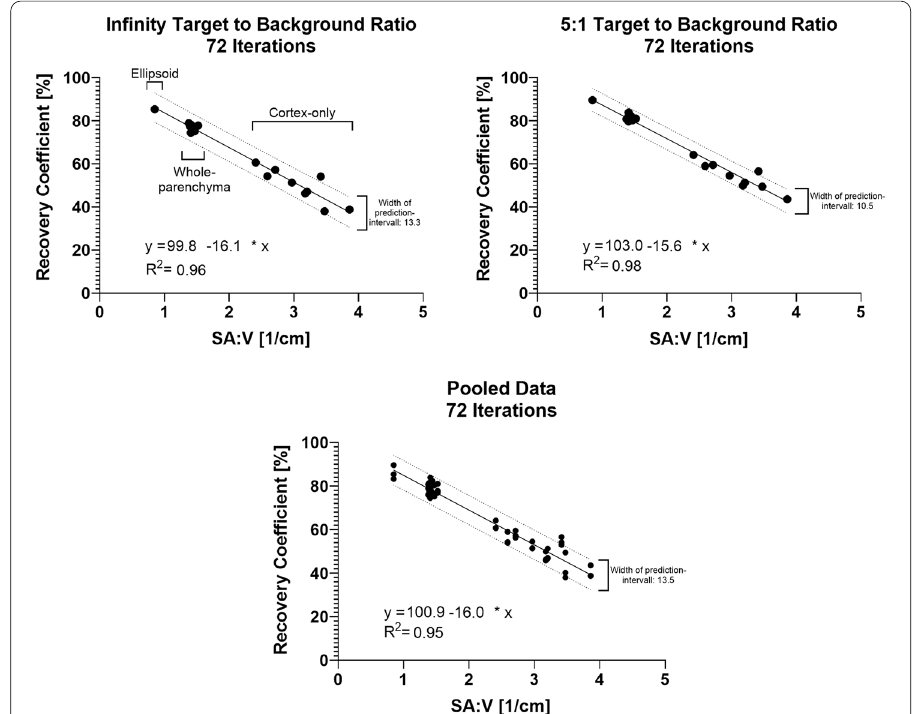
Fig. 5 Correlation of recovery coefficients and surface-area-to-volume ratio. Recovery coefficients vs. surface-area-to-volume (SA:V) ratios for all phantoms in the study. The infinity (cold background) (top left graph), 5:1 target-to-background ratios (top right), and the pooled data (bottom, infinity, 5:1 and 10:1 TBR) are shown with 72 iterations. Additionally, the best fit (solid line), the 95% prediction intervals (dashed lines) of the linear regression analysis, the average width of the prediction intervals, the equation of the best fit, and the goodness of fit (given as R-squared) are provided. The additional labels in the top left image indicate the position of the phantom type (ellipsoid. whole-parenchyma, cortex-only) in the graph. Values were obtained for LEHR collimation and the radionuclide 99m